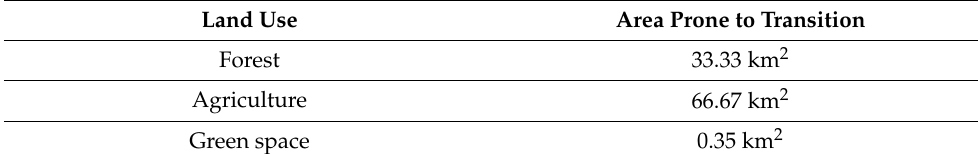
Table 9. Land-use classes prone to transition to built-up area.